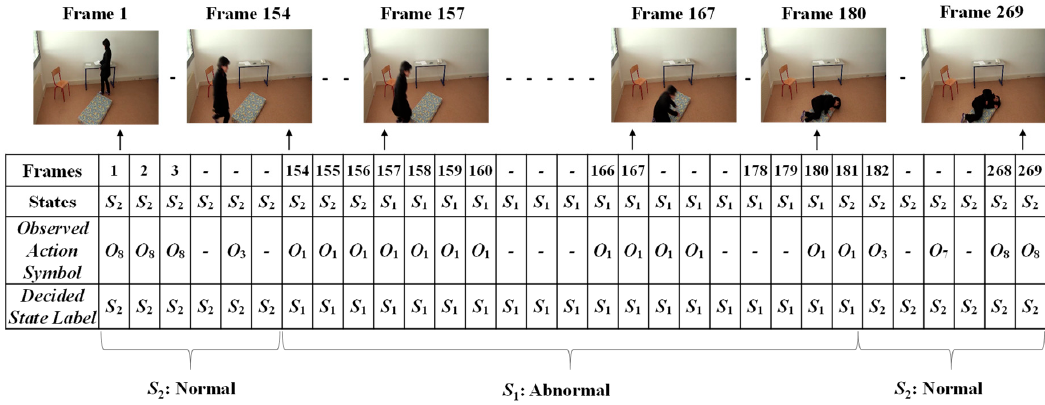
Figure 16. Results for deciding on the sequential abnormal and normal states for Ms. TWO (Video 1).